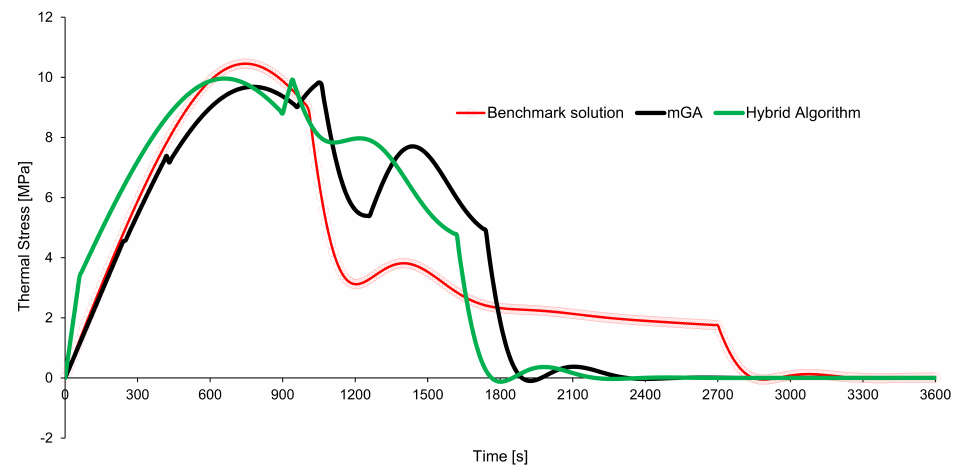
Figure 13. Comparison of the the thick-walled thermal stresses generated with the benchmark solution (red line), the micro genetic algorithm solution (black line) and the metaheuristic hybrid algorithm solution (green